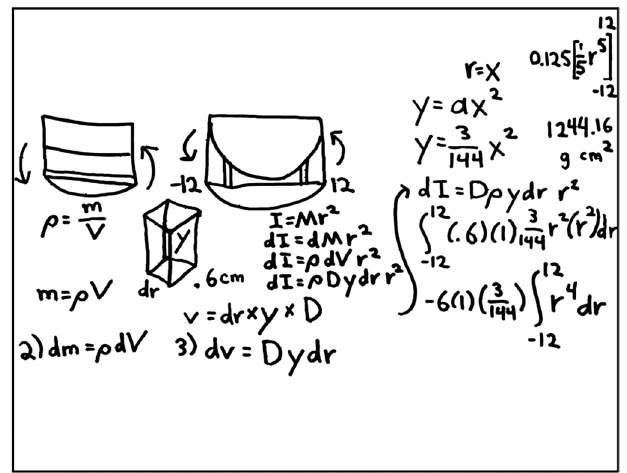
FIG. 4. Sketch of the blackboard after Amber’s lesson 5 pre-